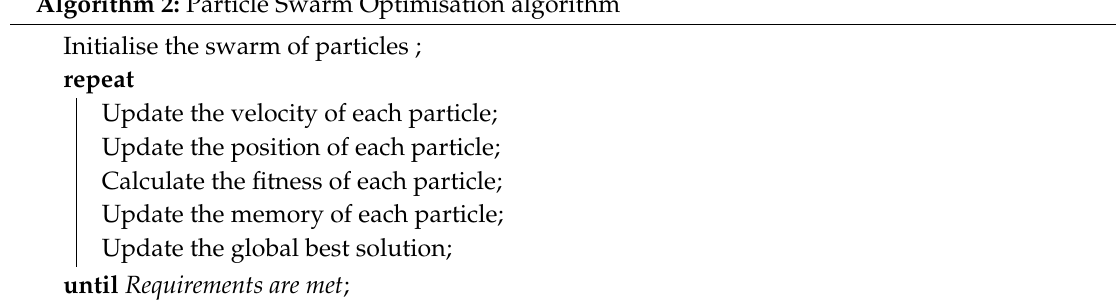
Algorithm 2: Particle Swarm Optimisation